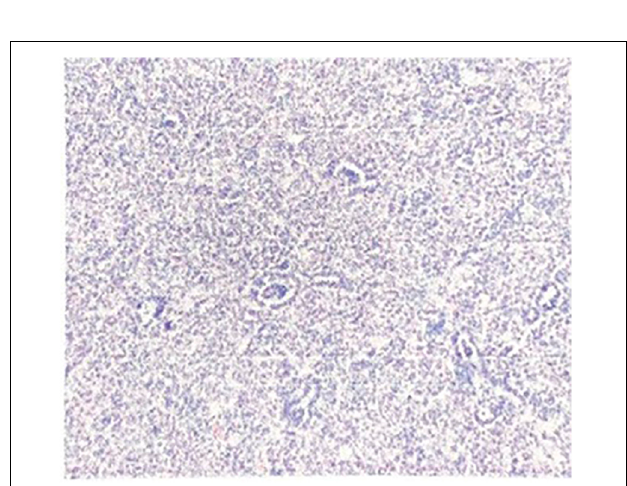
FIGURE 4 | Microscopic appearance of the metanephric adenoma (HE 10 ×